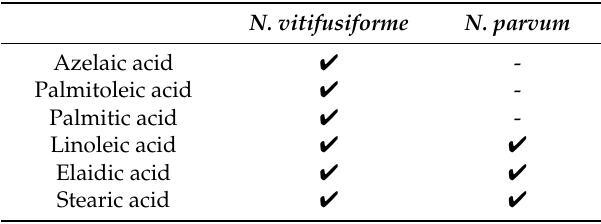
Table 1. An overview of qualitative results of compounds (i.e., fatty acids and dicarboxylic acids) produced in liquid medium by N. vitifusiforme and N. parvum.